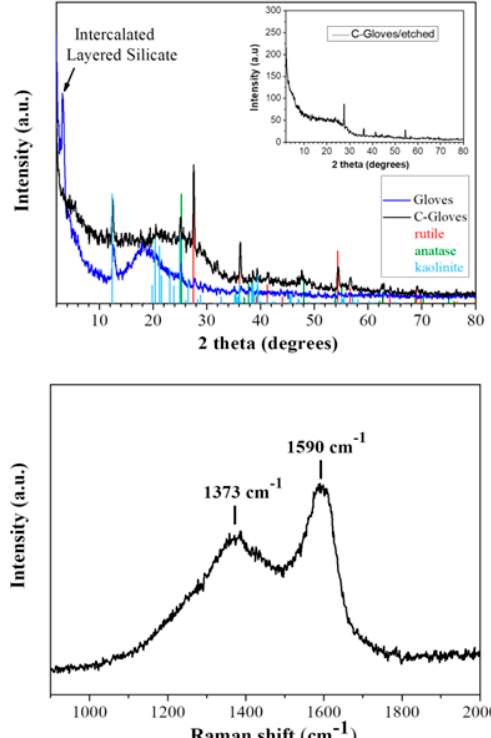
Figure 3. X-ray diffraction (XRD) pattern ( top ) and Raman spectrum ( bottom ) of C-GLOVE. The XRD pattern of the nitrile glove is also presented for comparison (blue line). The XRD pattern of the acid-etched C-GLOVE is given as inset.